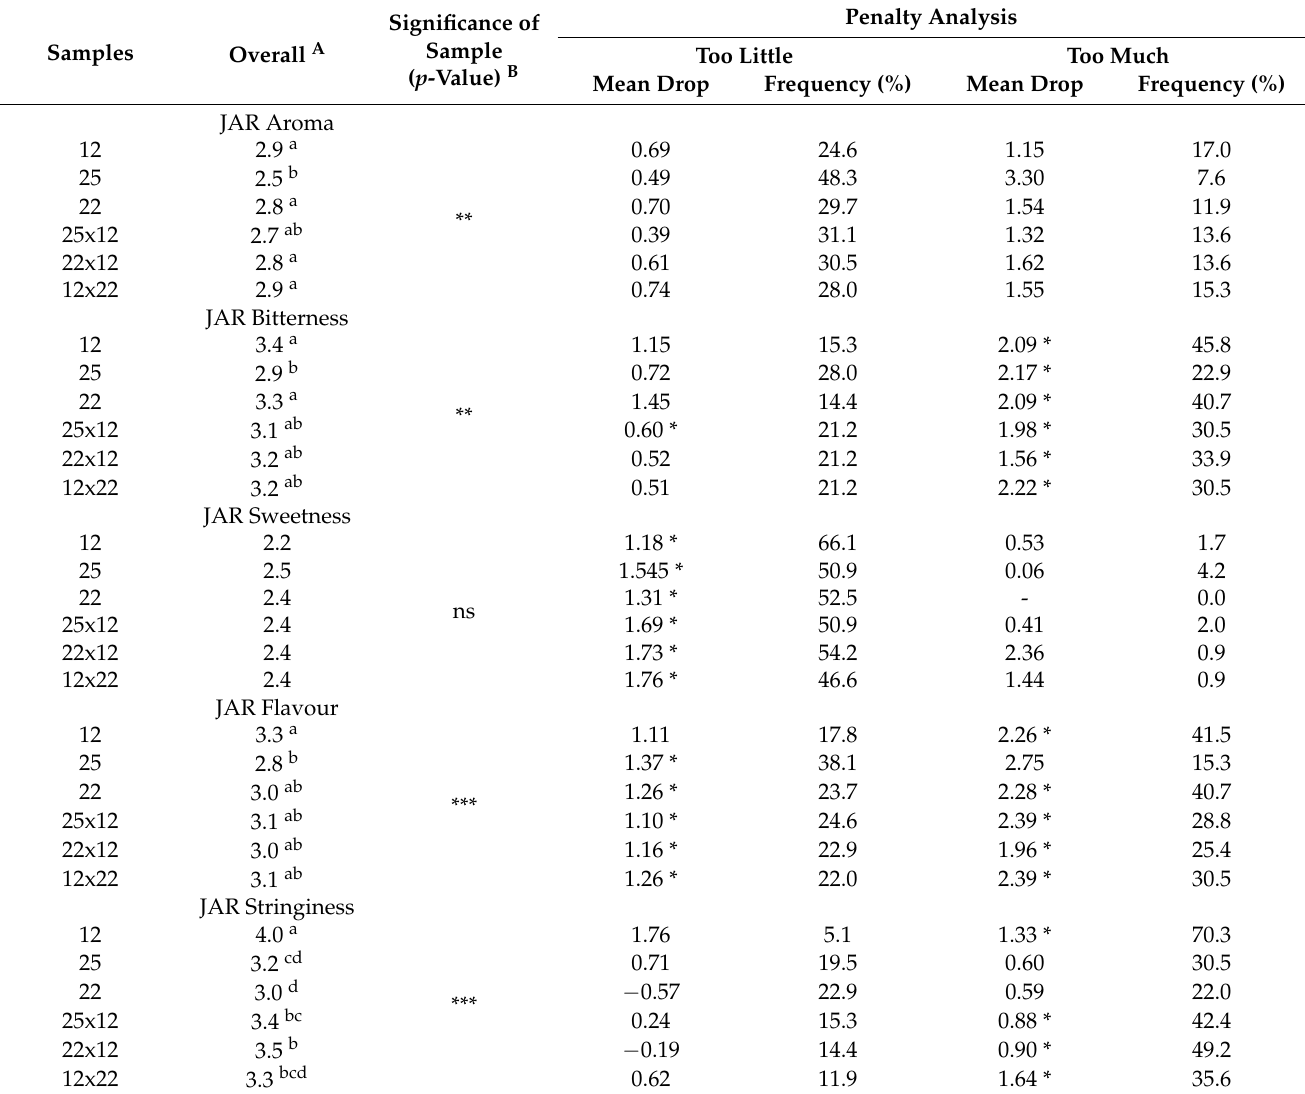
Table 7. Mean Just-About-Right ratings and penalty analysis showing the influence on overall liking ratings.